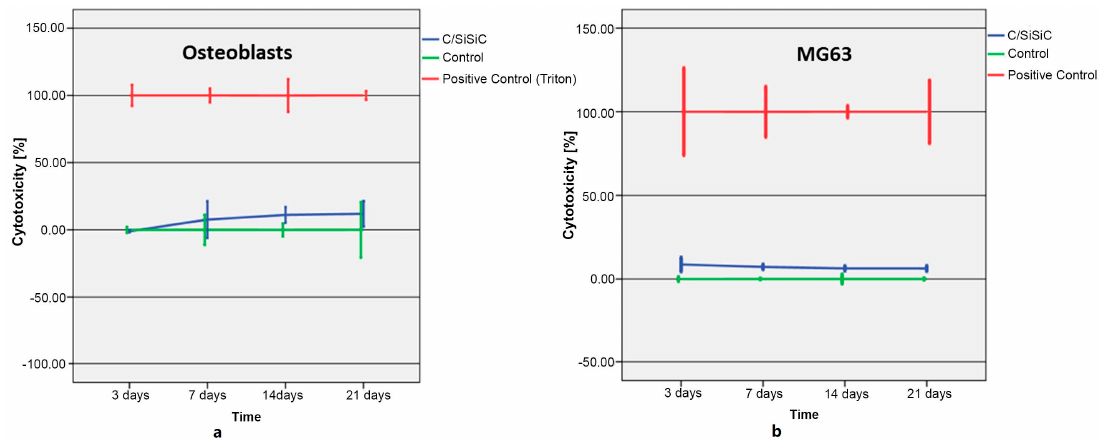
Figure 10. Cytotoxicity of samples versus that of human osteoblasts ( a ) and MG 63 ( b ) in per cent. Materials 2018 , 11 , x FOR PEER REVIEW